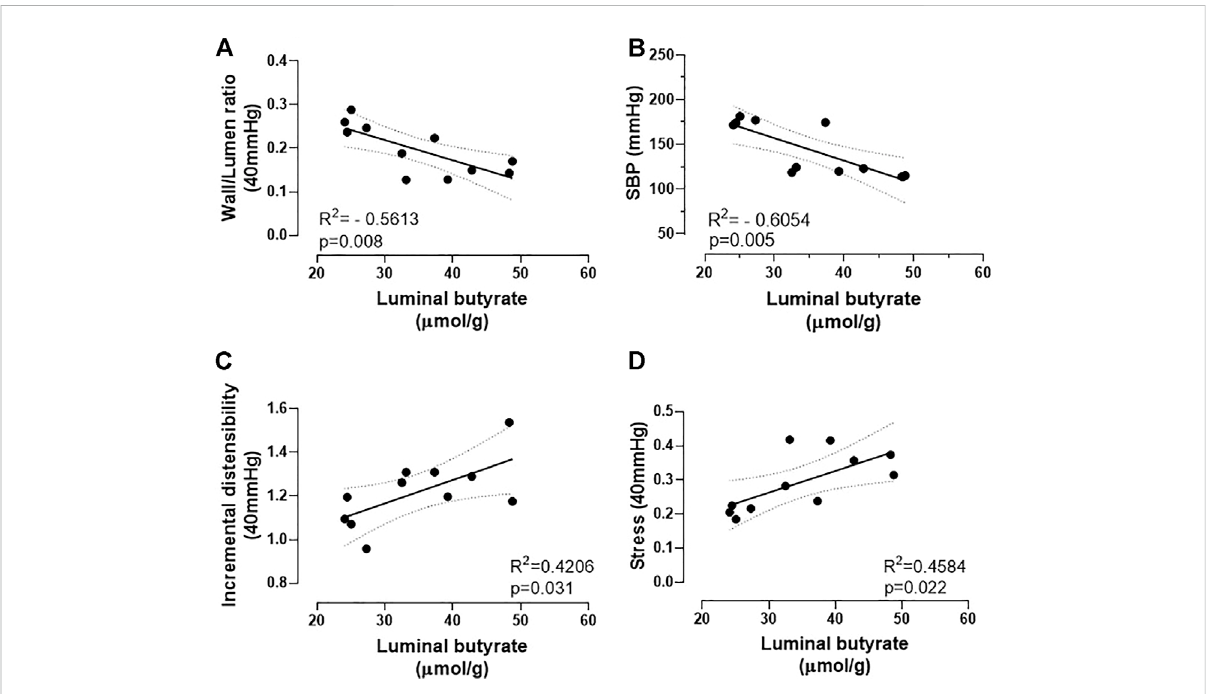
FIGURE 4 Correlations between structural and mechanical remodeling parameters of mesenteric resistance arteries or systolic blood pressure and intestinal butyrate availability. (A) negative correlation between wall/lumen ratio (a structural parameter) and (B) SBP with butyrate luminal content; (C) positive correlation between incremental distensibility and (D) stress with butyrate luminal content. Correlations were obtained by the Pearson correlation coef fi